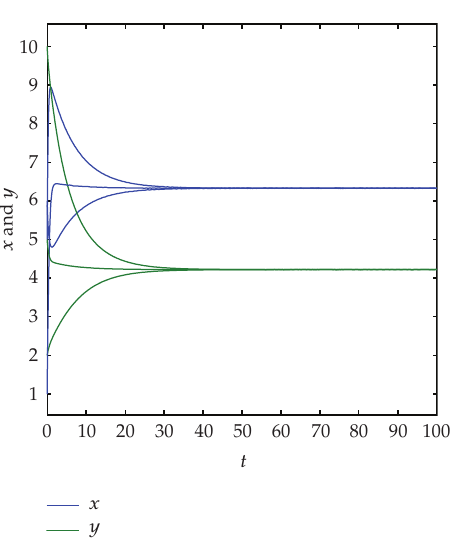
Figure 2: Solution curves of system (cid:6) 1.1 (cid:7) with the parameters given by Example 6.1 when r 1 (cid:8) 0 . 01.